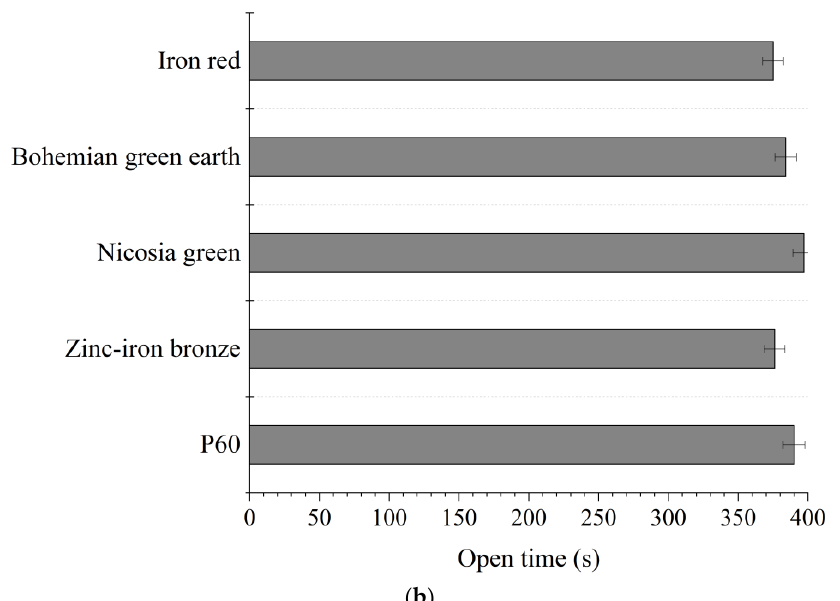
Figure 4. Effects of pigments on the vapor permeability ( a ) and open time ( b ) behaviour of paints.